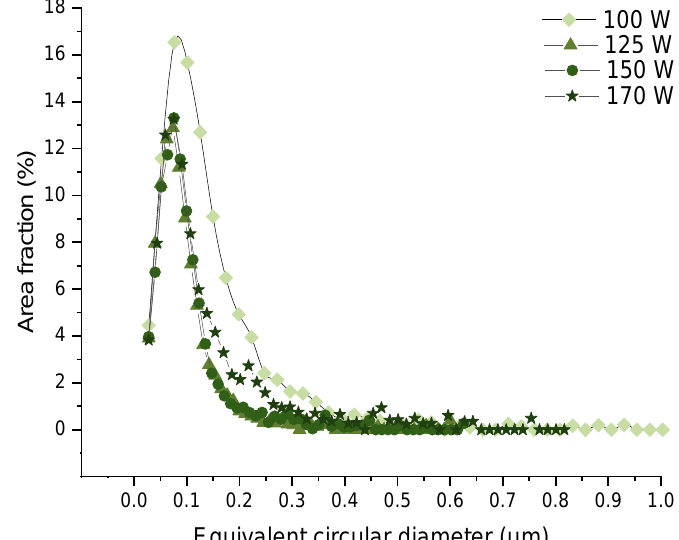
Figure 10. Power-dependent size distribution of spherical precipitates.